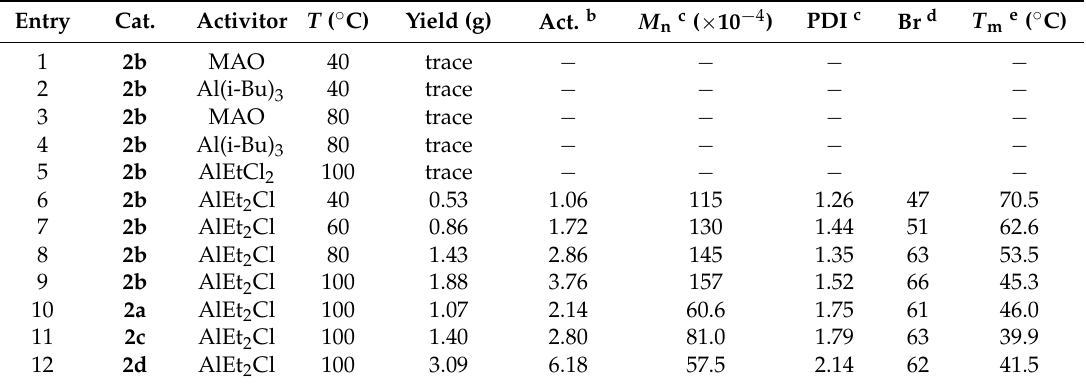
Table 2. Ethylene polymerization results with complexes 2a – 2d . a